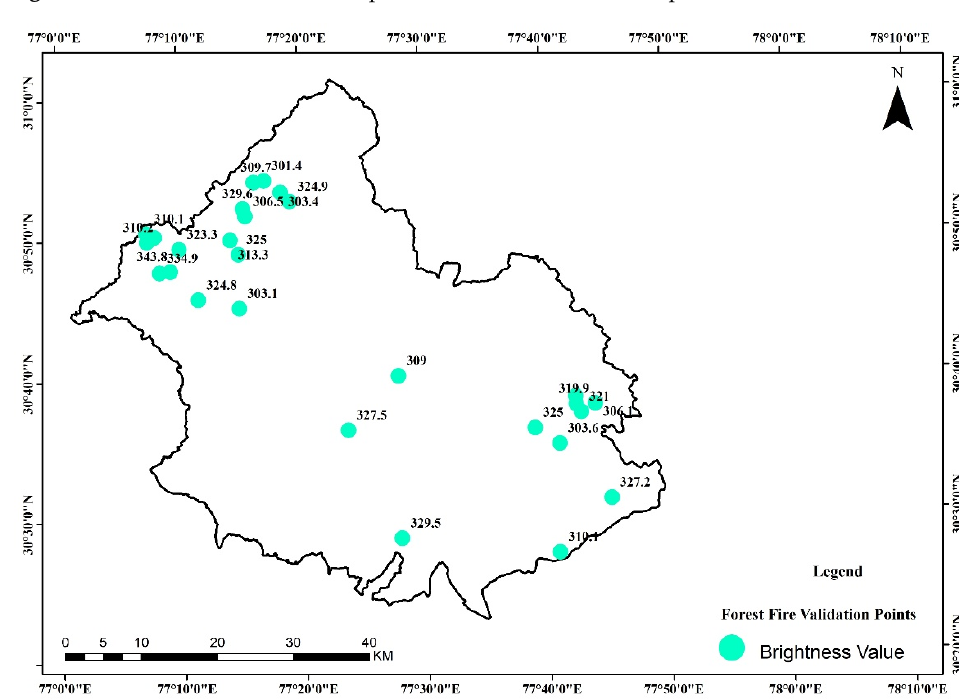
Figure 16. Modis point with its brightness values.